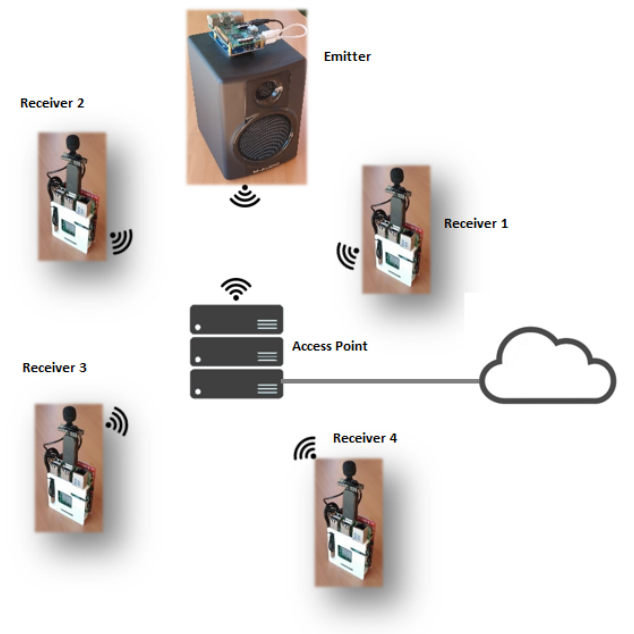
Figure 2. Diagram of the IoT architecture for the room acoustics parameter measurement